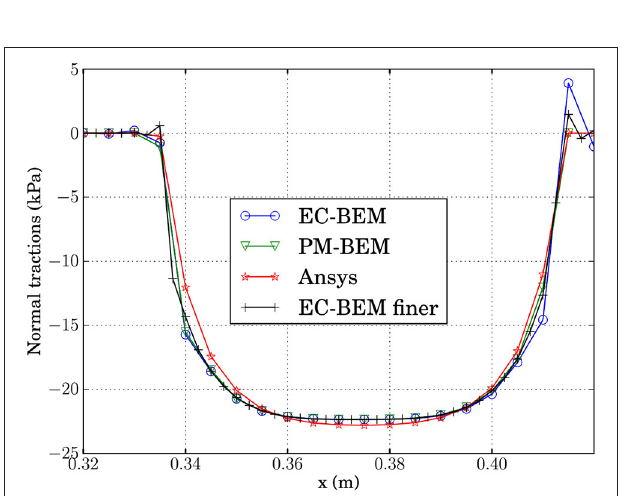
FIGURE 12 | Comparison of tractions computed along the contact zone by the algorithm described here (EC-BEM) and the point method with BEM (PM-BEM) and the FEM code ANSYS using an Augmented Lagrange algorithm. The EC-BEM solution corresponds to model A with Mesh 1, while a finer one also included here, for model B with Mesh 2 (see Tables 3 , 4 , respectively).